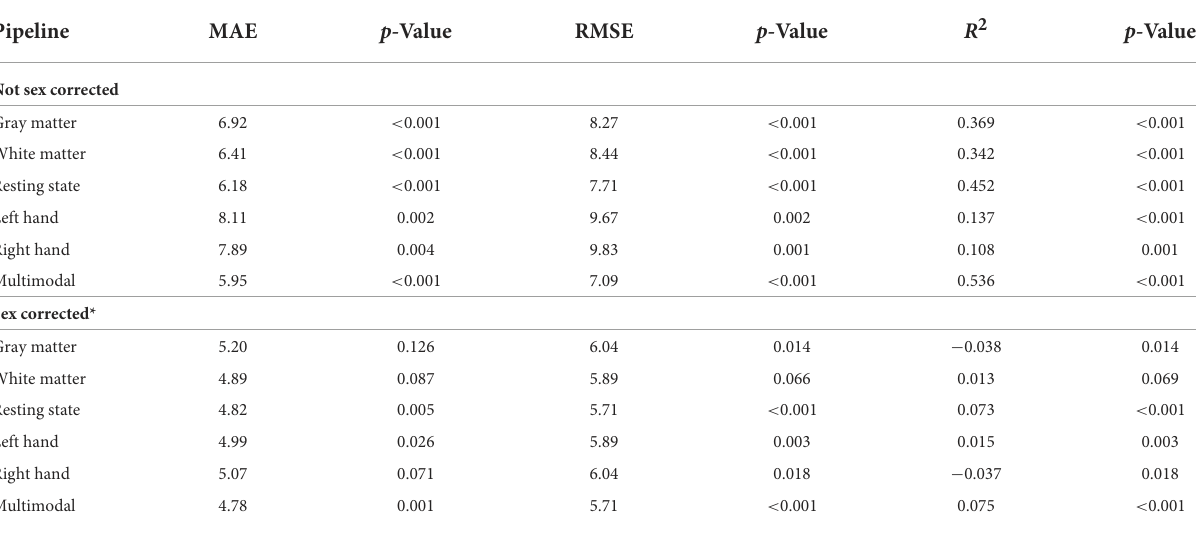
TABLE 2 Grip strength prediction testing performance ( n =